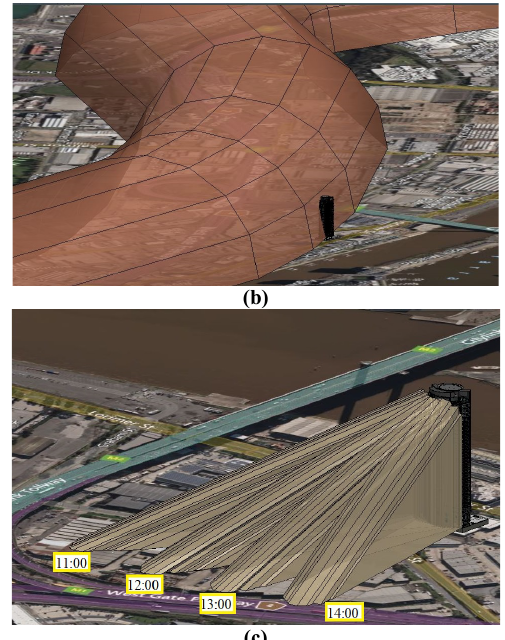
(c) Figure 8 . Modelled LuRs; a) height limits, b) noise impacts, and c) volumetric shadow in four specified